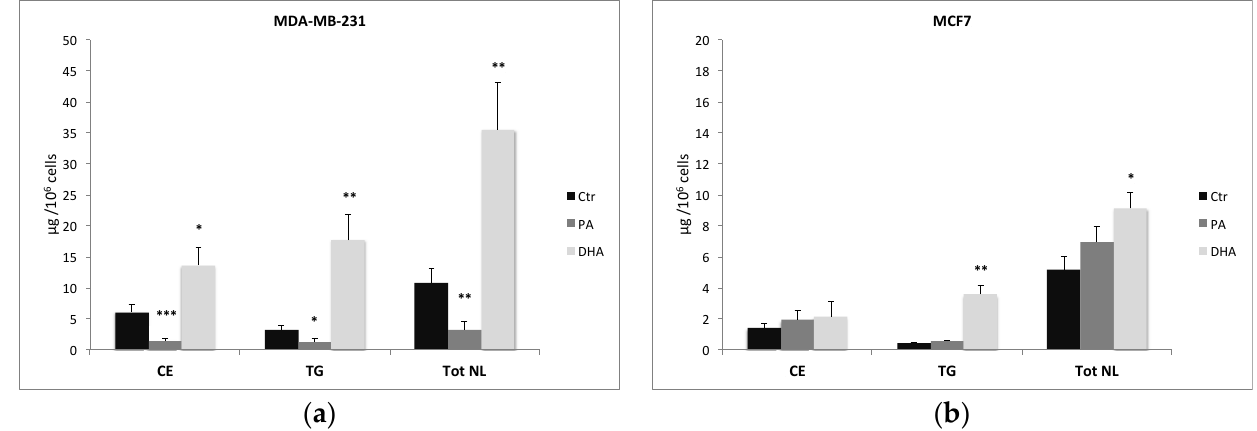
Figure 2. Content ( μ g/10 6 cells) of total neutral lipids (NL), cholesteryl esters (CE), and triglycerides (TG) isolated from breast cancer cells MDA ‐ MB ‐ 231 ( a ) and MCF7 ( b ) treated with PA or DHA (50 μ M) for 72 h: data are represented as mean ± SE obtained from four independent experiments. (* p < 0.05, ** p < 0.01, and *** p < 0.001 vs. Ctr cells of the same line).